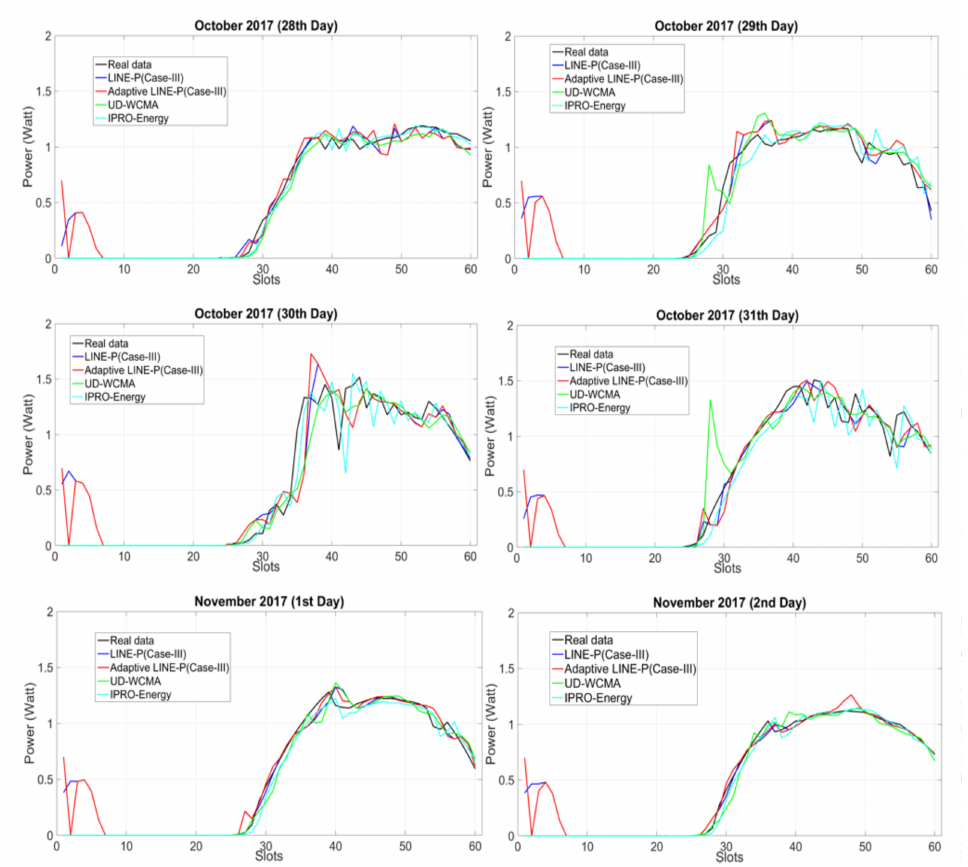
Figure 4. Graphical representation of Adaptive LINE-P (Case III) and the state of the art based on the medium (22-min data interval) time period horizon for the solar energy profile with 61 time slots in 24